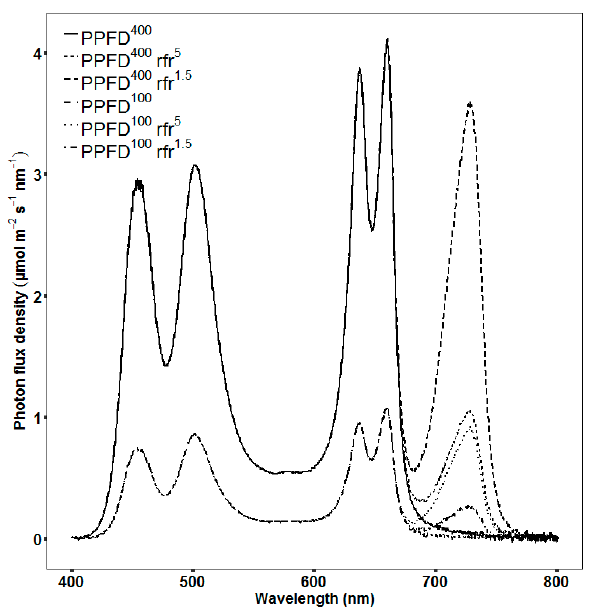
Figure 2. Spectral photon flux density of the six light treatments in the first experiment at high (PPFD 400 ) and low (PPFD 100 ) photosynthetic photon flux density (PPFD) and high (rfr 5 ) and low (rfr 1.5 ) red to far-red ratio (R:FR).